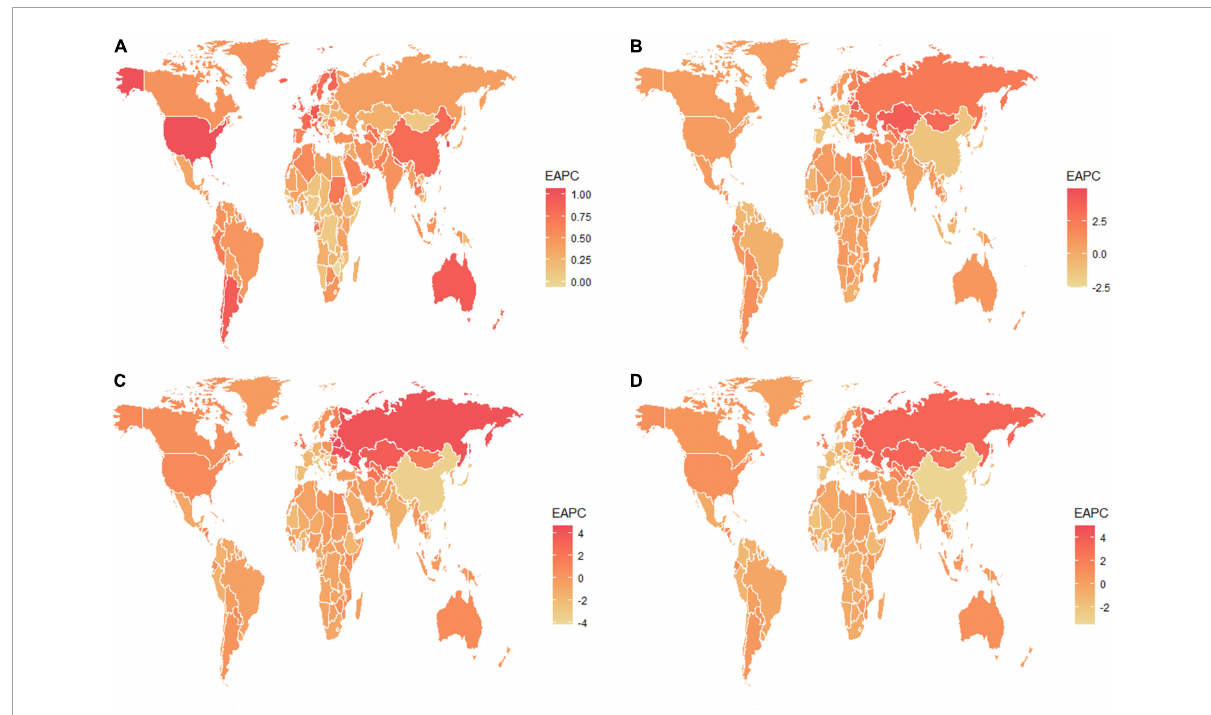
FIGURE2 The estimated annual percentage changes of the global age-standardized (A) prevalence, (B) incidence, (C) DALY, and (D) death rates from 1990 to 2019. EAPC, estimated annual percentage change; DALY, disability-adjusted life years.